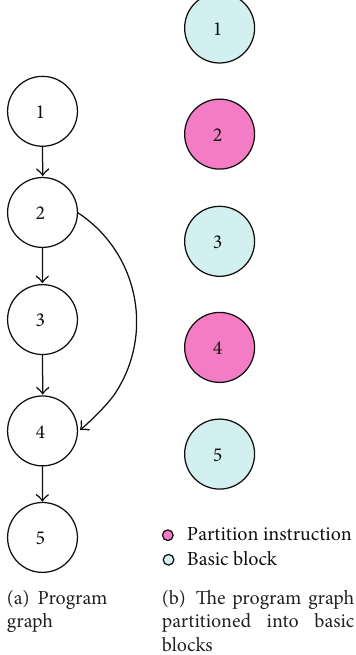
Figure 1: Program dividing into some basic blocks [11].